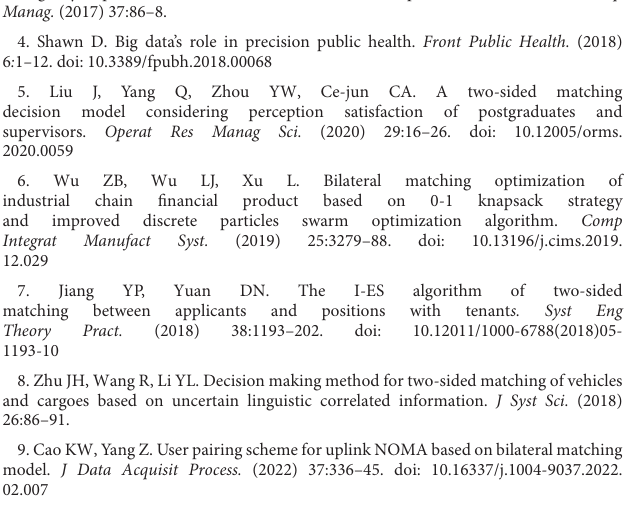
algorithm of two-sided